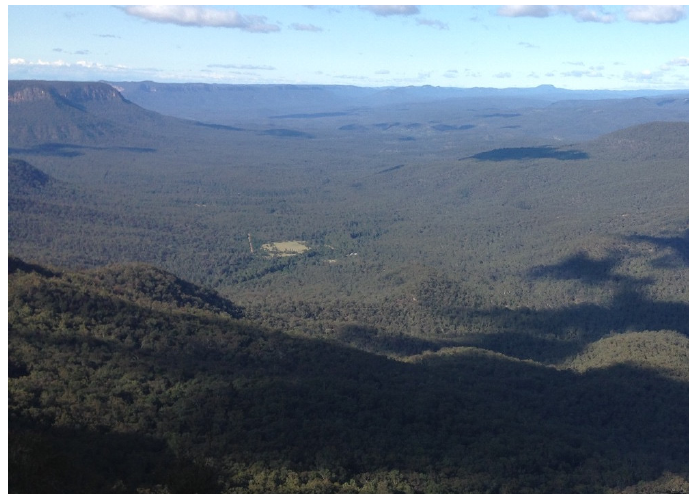
Figure 2. View of Kedumba valley facing south. The grassland areas visible near the middle of the picture are the regions named Open grassland 1 and 2. Image A.M. Harvey.